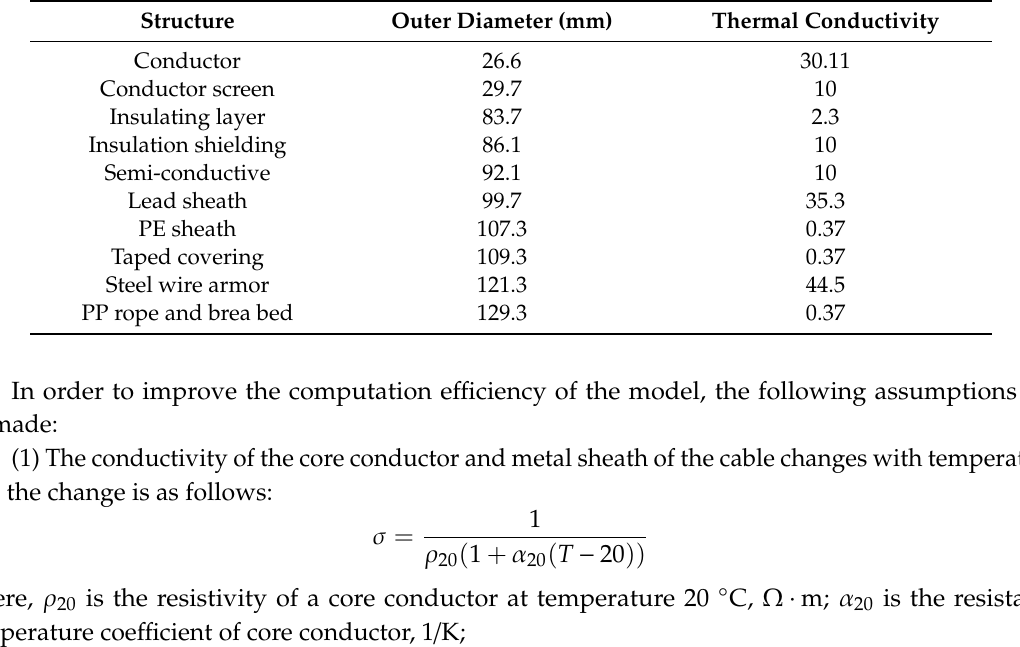
Figure 1. Schematic diagram of submarine cable structure. Table 1. The specific parameters of submarine cable.